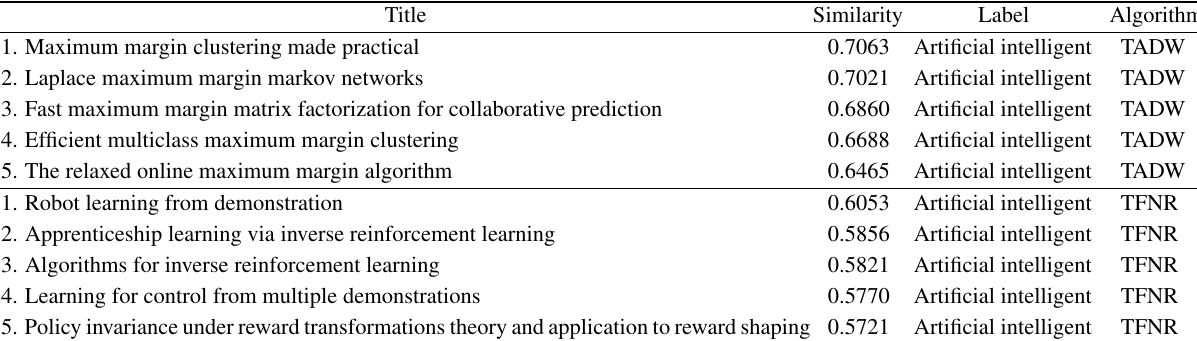
Table 6 Five nearest neighbors generated by DeepWalk and